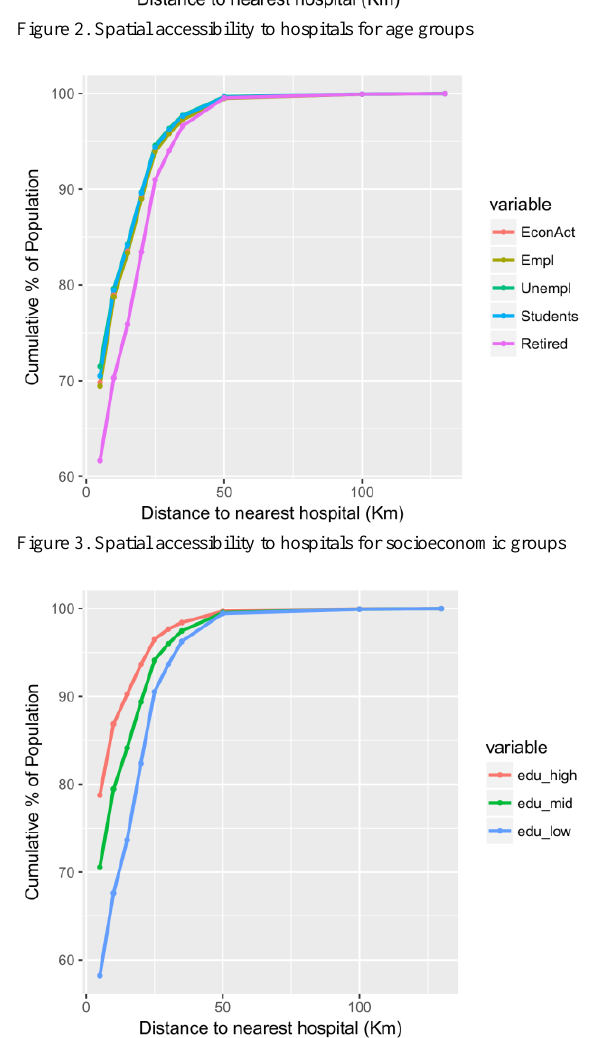
Figure 4. Spatial accessibility to hospitals for groups by educational